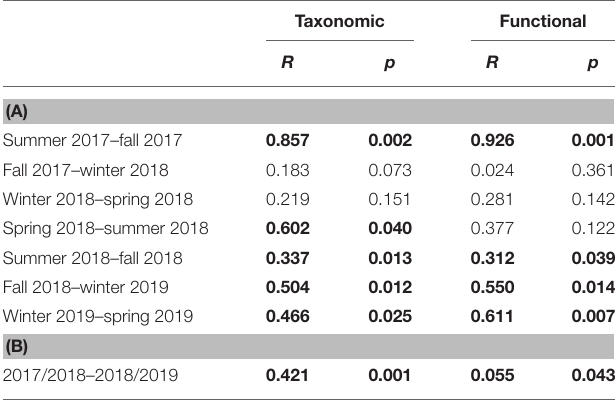
TABLE 1 | Results of the ANOSIM to analyze the differences in taxonomic and functional community composition between (A) seasons and (B) years. Taxonomic